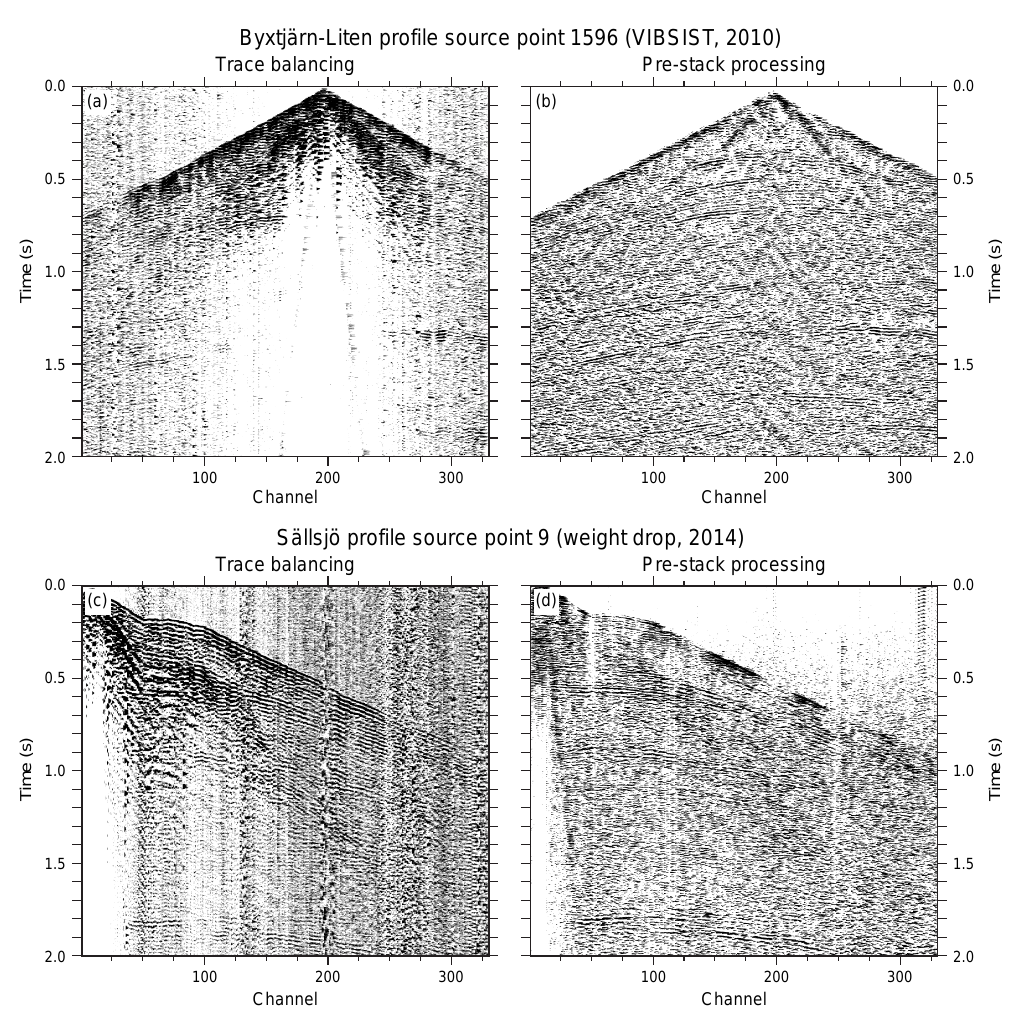
Figure 4. Two examples of source gathers before and after processing. (a) VIBSIST source gather from the Byxtjärn-Liten profile from the south shore of Lake Liten (Fig. 2) with only trace balancing applied. (b) The same source gather as in (a) after processing. (c) Weight-drop source gather from the Sällsjö profile from the eastern end of Lake Liten with only trace balancing applied. (d) The same source gather as in (c) after